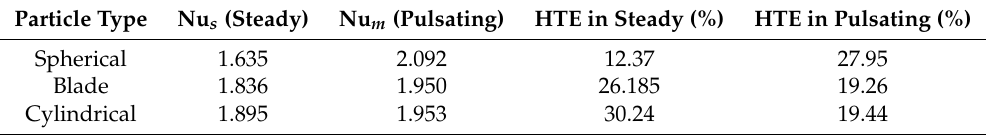
Figure 12. The average Nusselt number versus the Strouhal number for different nanoparticle volume fractions with spherically-shaped particles. Table 5. Spatial-temporal average Nusselt number for various particle shapes at a Strouhal number of 0.1 and φ = 0.04. HTE, Heat Transfer